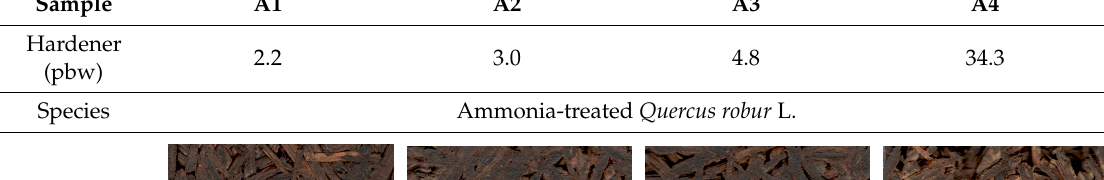
Table 6. Sample appearance of boards made from ammonia-treated oak.